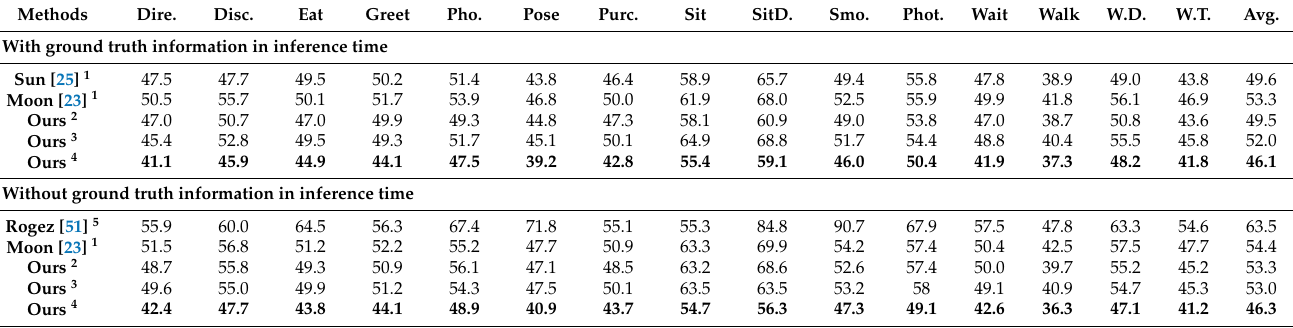
Table 3. Quantitative comparisons with the base model on the Human3.6M under Protocol 2 (MPJPE). Best results are in bold.